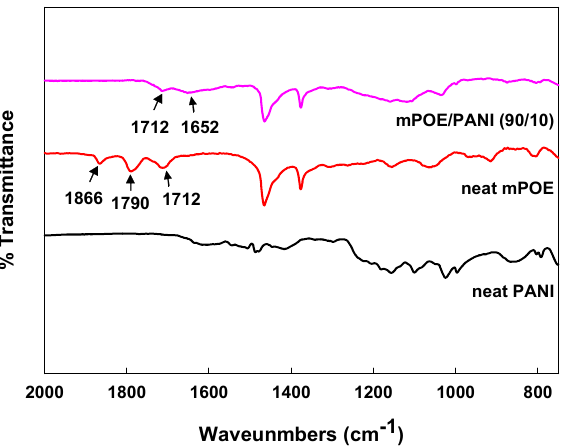
Figure 2. FT-IR spectra of neat PANI, neat mPOE and mPOE/PANI (90/10) blend .